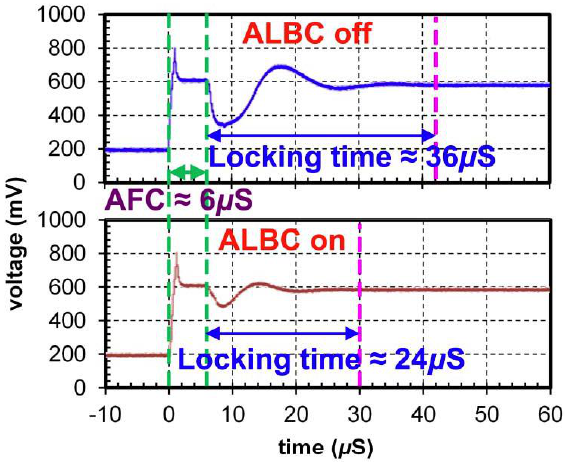
Figure 15. Measured lock-time comparison when the ALBC off/on. A summary of the performance of the proposed frequency synthesizer and comparison with other state-of-the-arts is presented in Table 1, exhibiting high frequency, wide tuning range, low phase noise, fast locking time with slight chip area and power